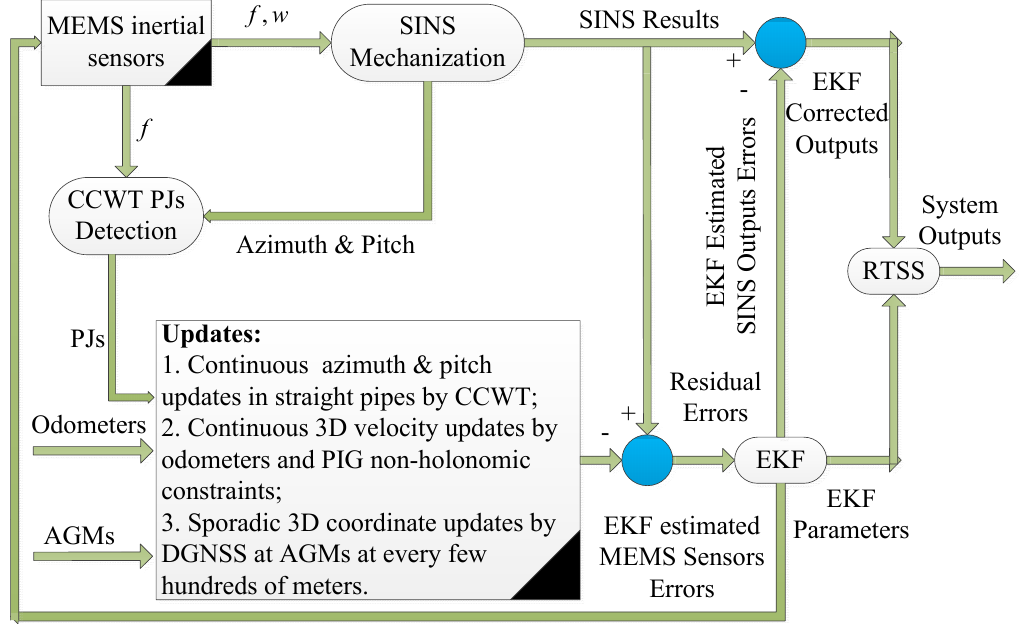
Figure 8. Schematic of SINS/Odo/AGM/Pipeline Junction (PJ) -based intelligent PIG surveying